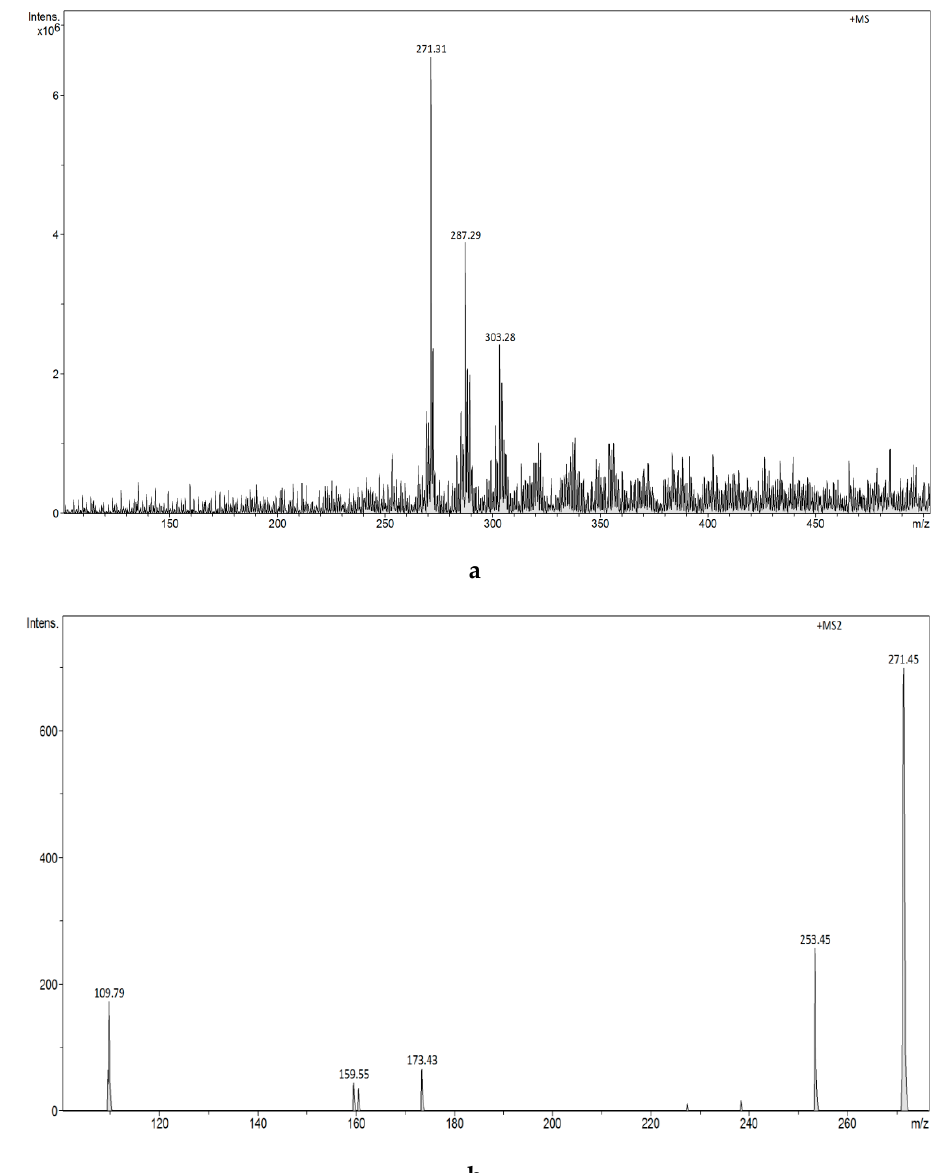
Figure 11. ( a ) FAPA-MS (positive ions) spectrum of E2. ( b ) FAPA-MS 2 fragmentation spectrum of the m/z 273 ion observed for E2. ( c ) FAPA-MS 2 fragmentation spectrum of the m/z 269 ion observed for E2.